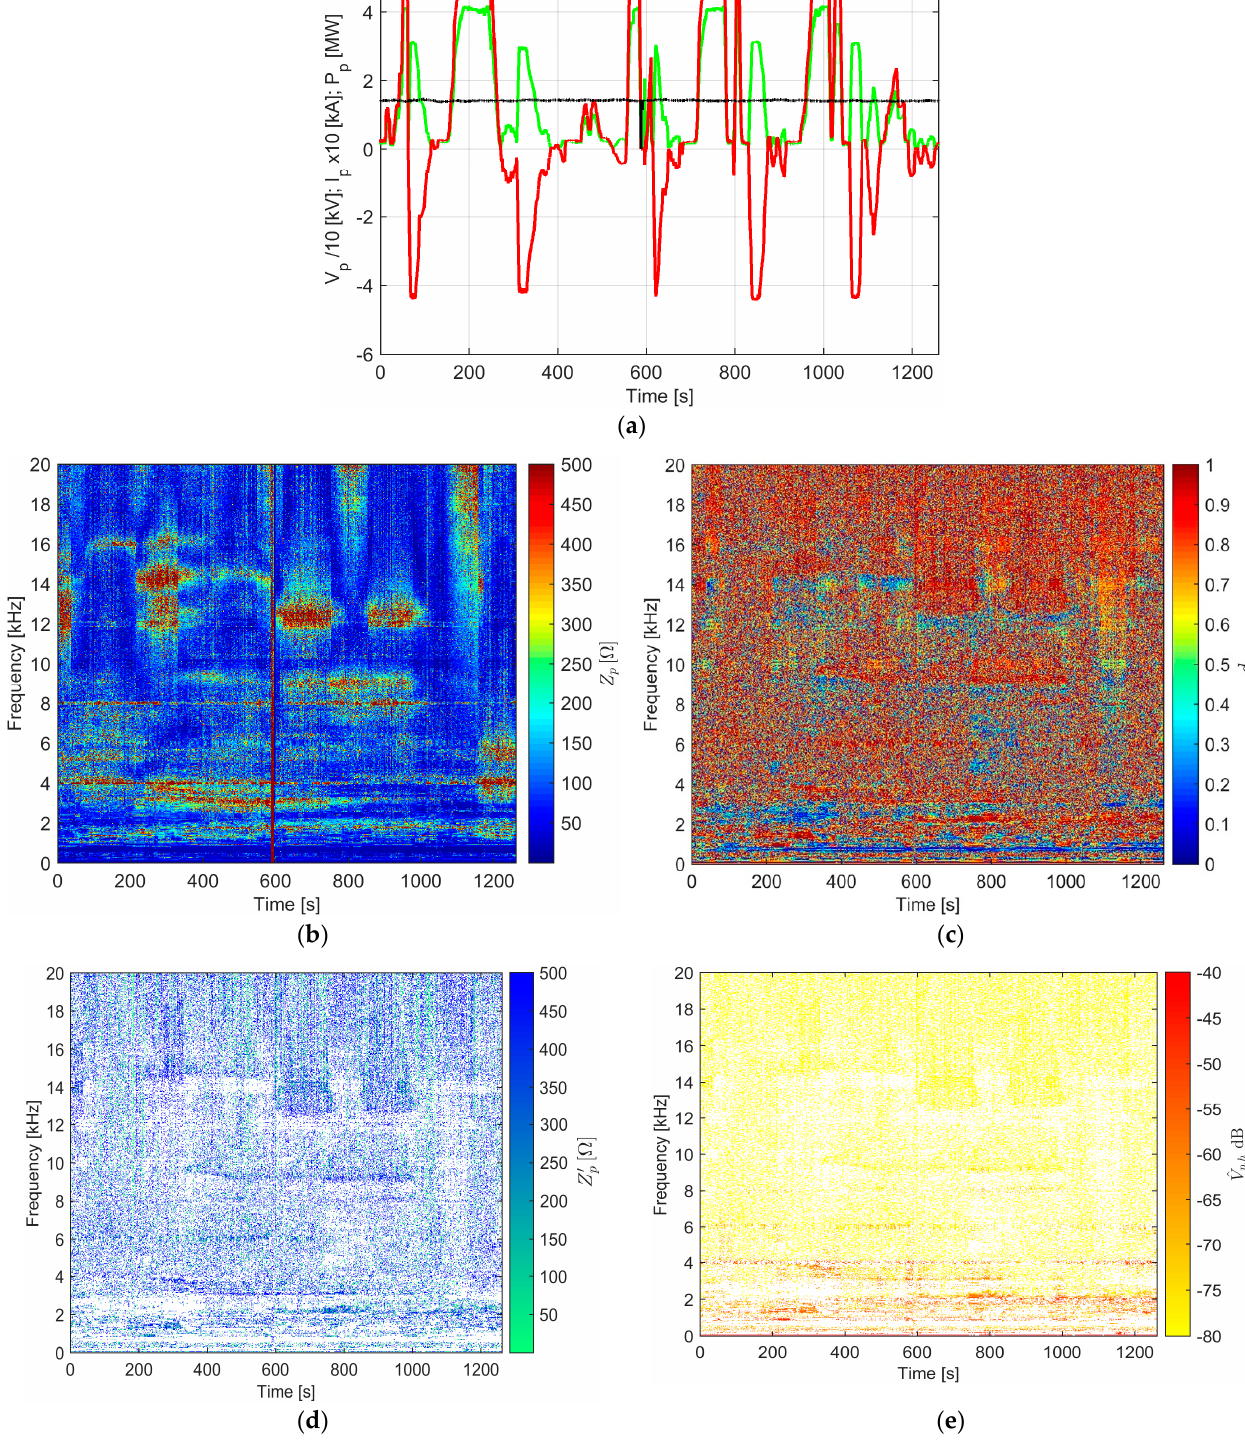
Figure 2. Switzerland example: ( a ) voltage (black), current (green), and active power (red) profiles; ( b ) harmonic impedance Z p ; ( c ) harmonic displacement factor d h ; ( d ) filtered impedance Z ′ p ; ( e ) normalized harmonic voltage ˆ V p , h